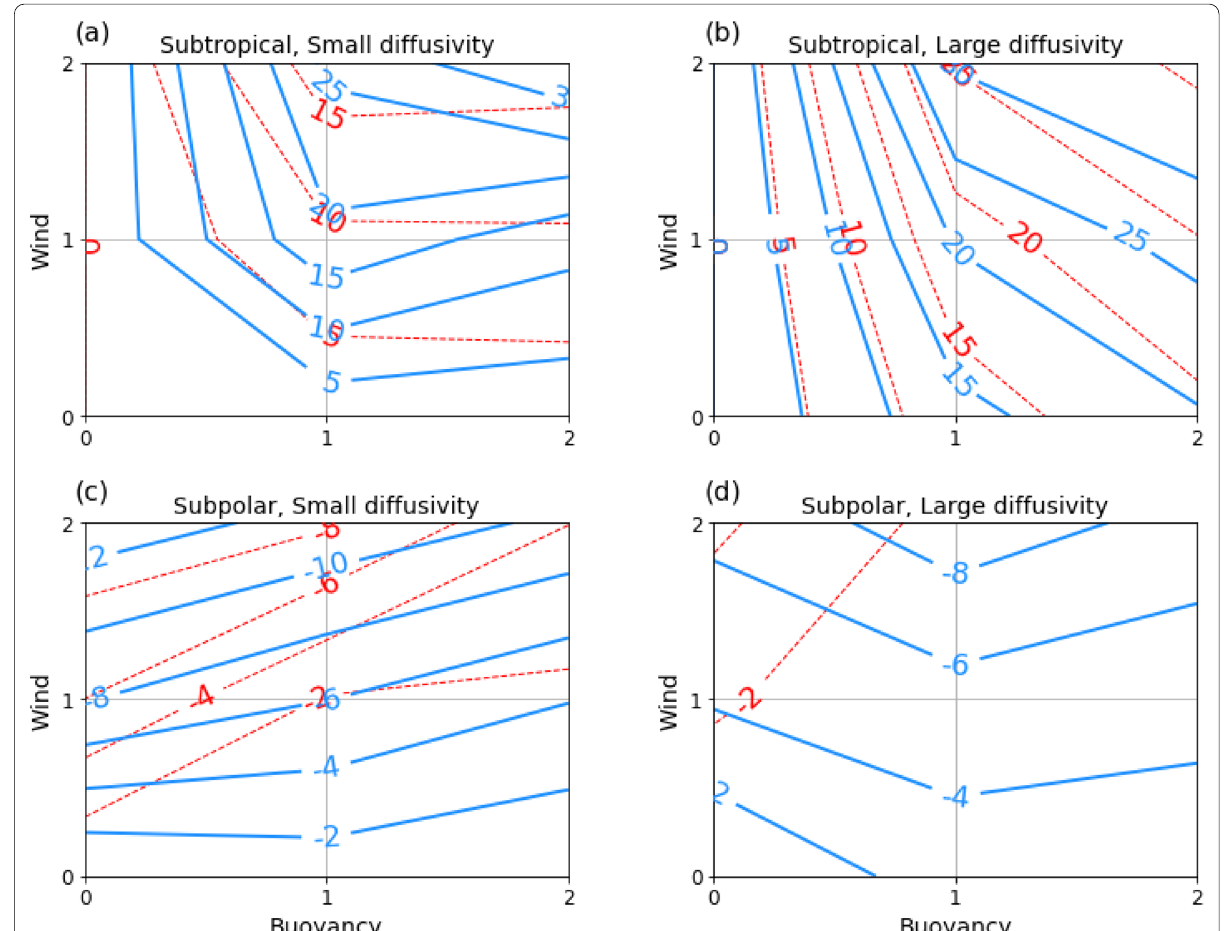
Fig. 4 The dependence of a , b subtropical and c , d subpolar gyres on the wind and buoyancy forcing for both small and large vertical diffusivity. Contours represent the strength of gyres in different experiments, with red and blue contours representing the non‑eddy and eddy‑resolving solutions, respectively. Values of 0, 1, and 2 in the buoyancy (wind) axis represent no‑buoyancy (wind), reference, and double‑buoyancy (wind) cases (listed in Table 1),